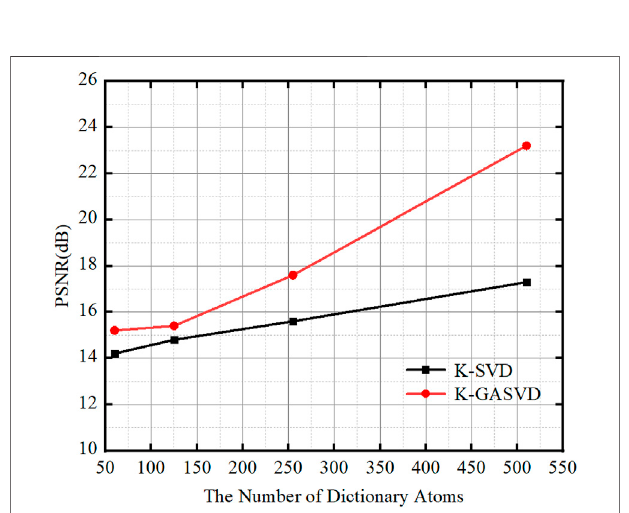
FIGURE 8 | The relationship between the PSNR value of the image obtainedbasedonK-SVDandK-GASVDandthenumberofdictionaryatoms.